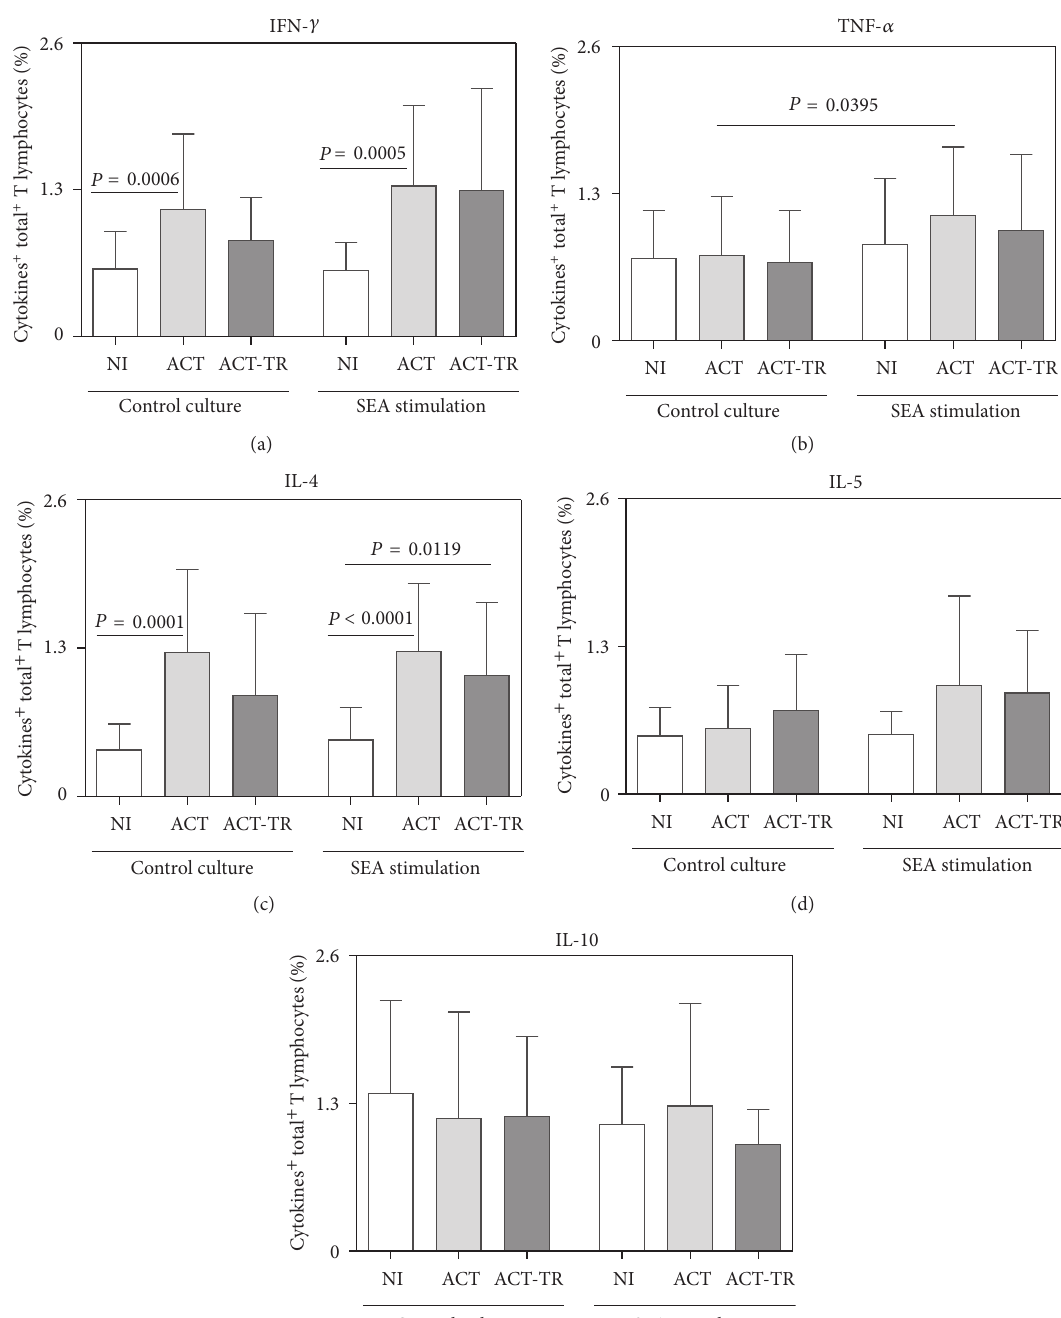
F 2: Cytokine pattern of circulating T lymphocytes from patients with acute Schistosomiasis mansoni before (ACT, faint grey square = 21) and aer praziquantel treatment (ACT-TR, grey square = 07) and noninfected individuals (NI, white square = 19), following short-term in vitro cultivation in the absence (control culture) or presence of SEA stimulation. e results are shown in bar-plot format highlighting the mean percentage of datasets standard deviation. Statistically signi�cant di�erences (connecting lines) observed between groups NI, ACT, and ACT-TR were considered at ± 𝑃𝑃 𝑃 𝑃𝑃𝑃𝑃